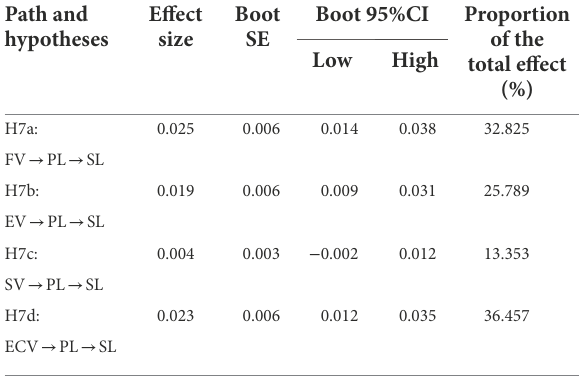
TABLE 9 Bootstrapping analysis results of the mediation effect. Path and